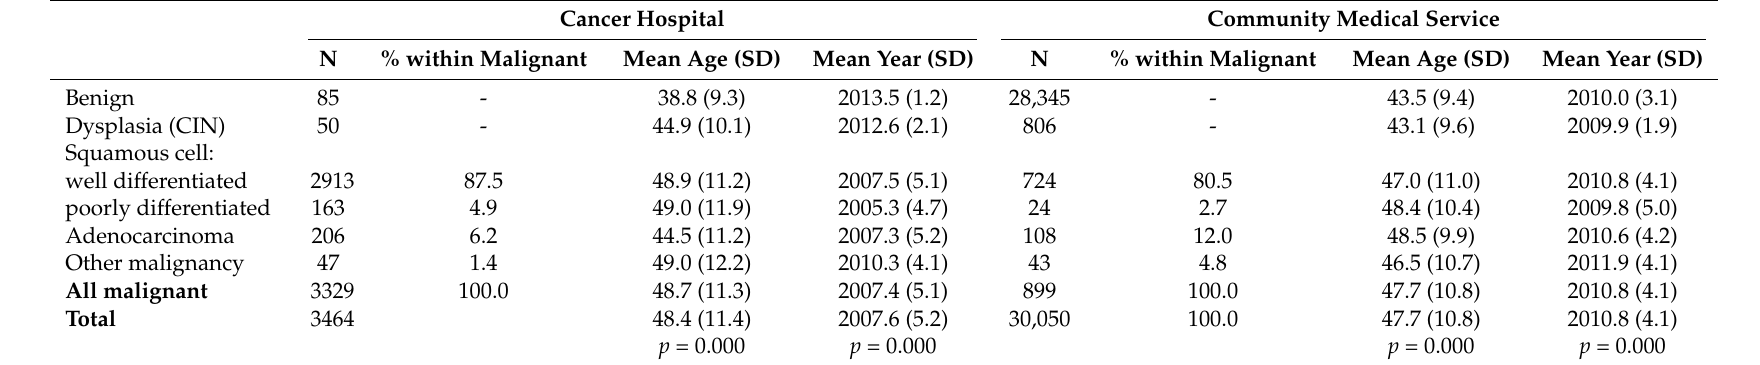
Table 1. Histopathology of malignant cases with mean age and year of diagnosis.